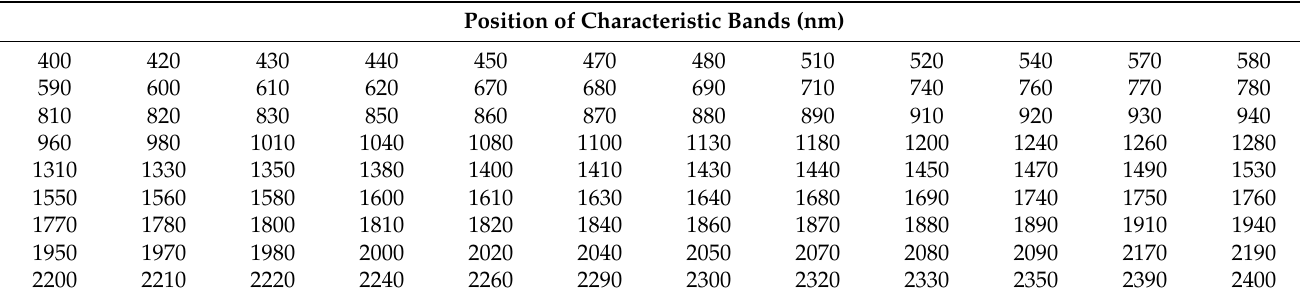
Table A4. Characteristic bands of CR-SD selected by GA.